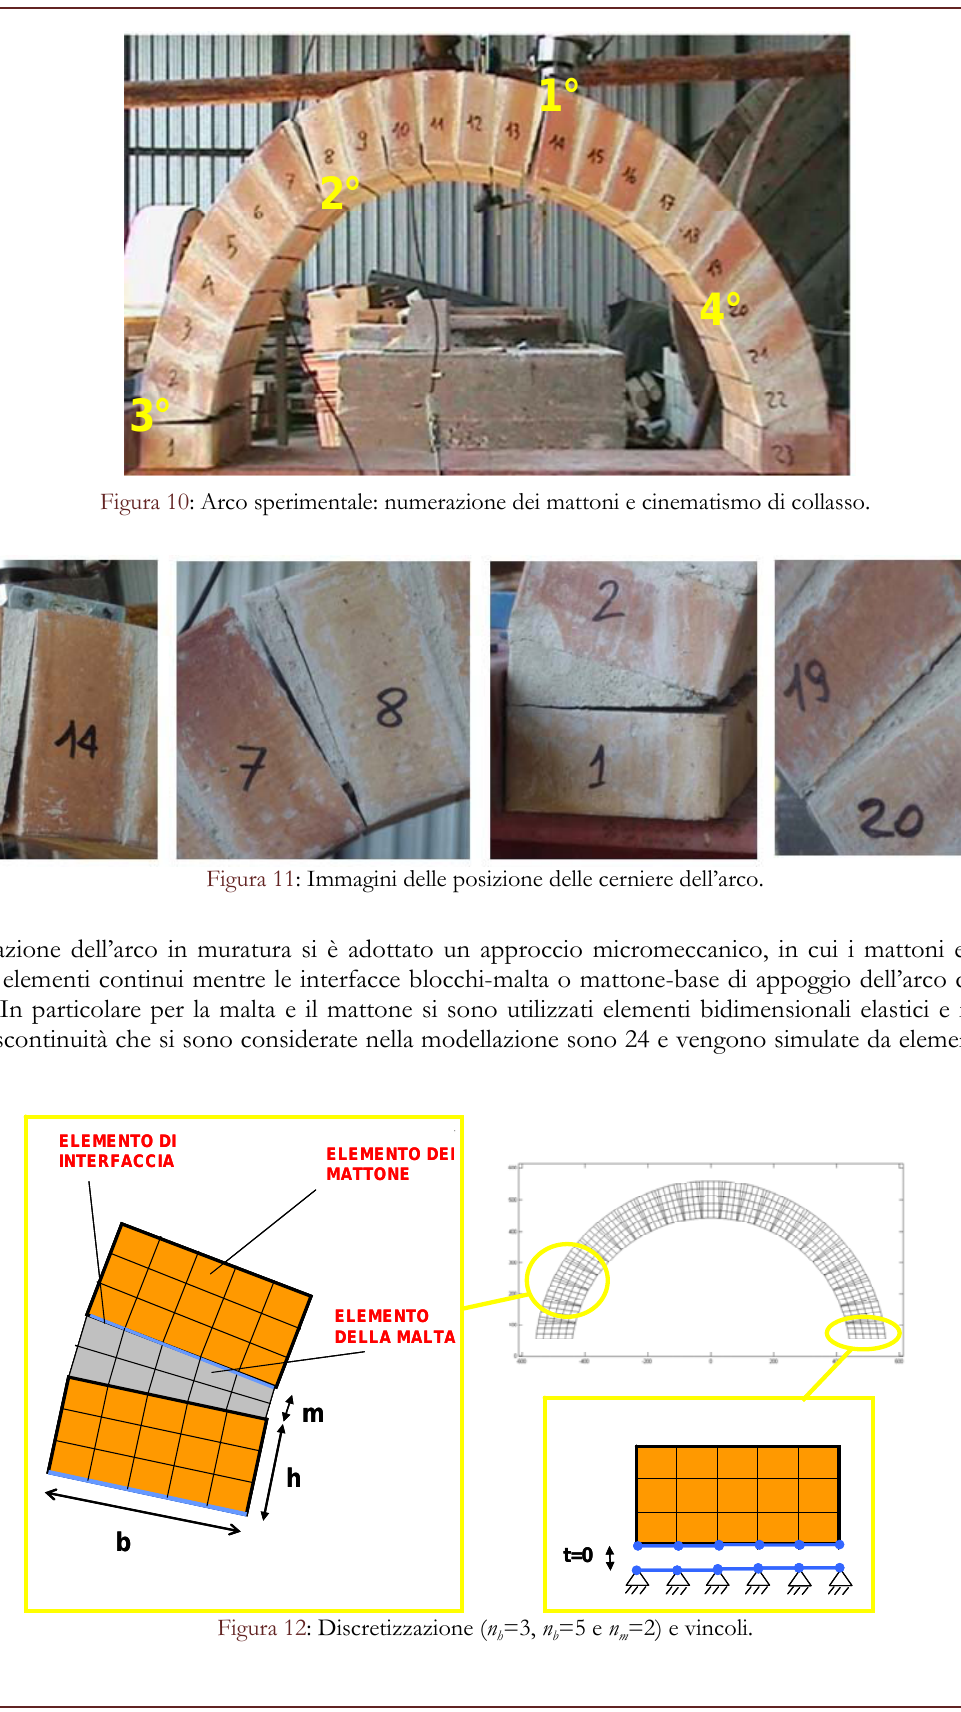
=3, n =5 e n =2) e h b m